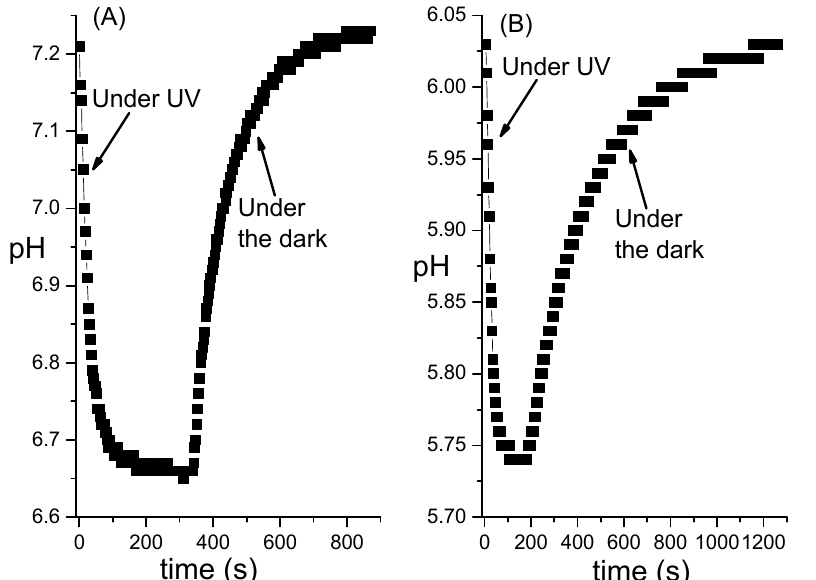
Figure 8. pH changes generated by [ t -DZH ] = 1 × 10 − 4 M dissolved in H 2 O/CH 3 CN = 1/1 ( A ) and in an aqueous micellar solution of SB3-14 0.1 M ( B ). The pH drops were photo-induced using the same irradiation source (see Figure S16 and the end of Section 3.3 for more details).